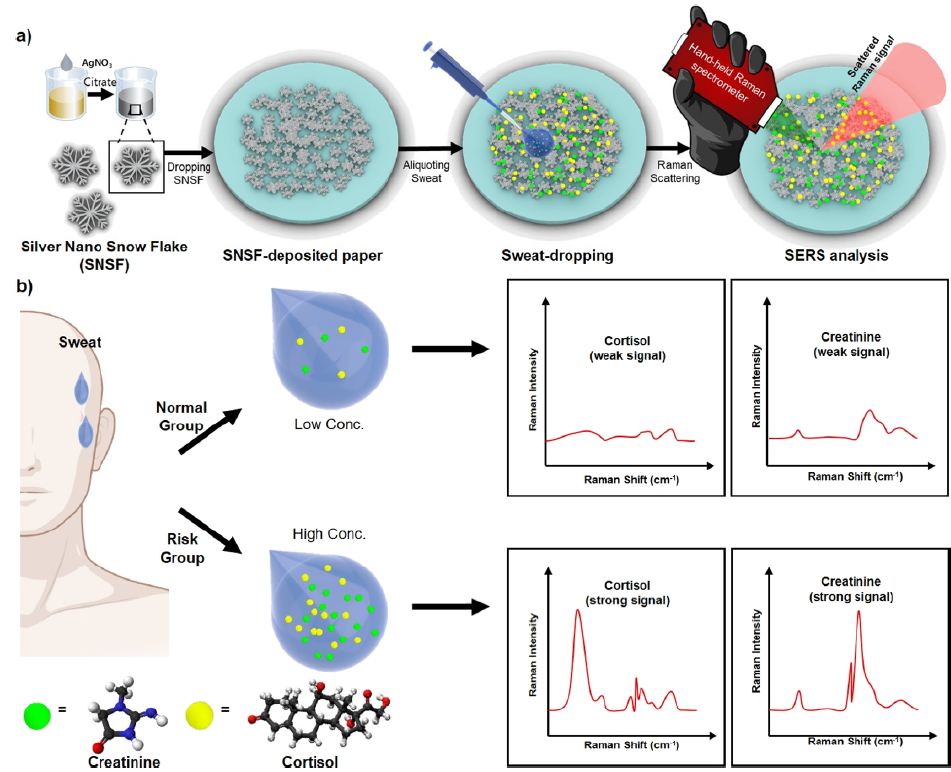
Figure 4. ( a ) Detection of stress biomarkers in sweat, ( b ) sweat sampling for the classification of normal and risk groups (reproduced with permission from [52] . Copyright 2021 American Chemical Society).